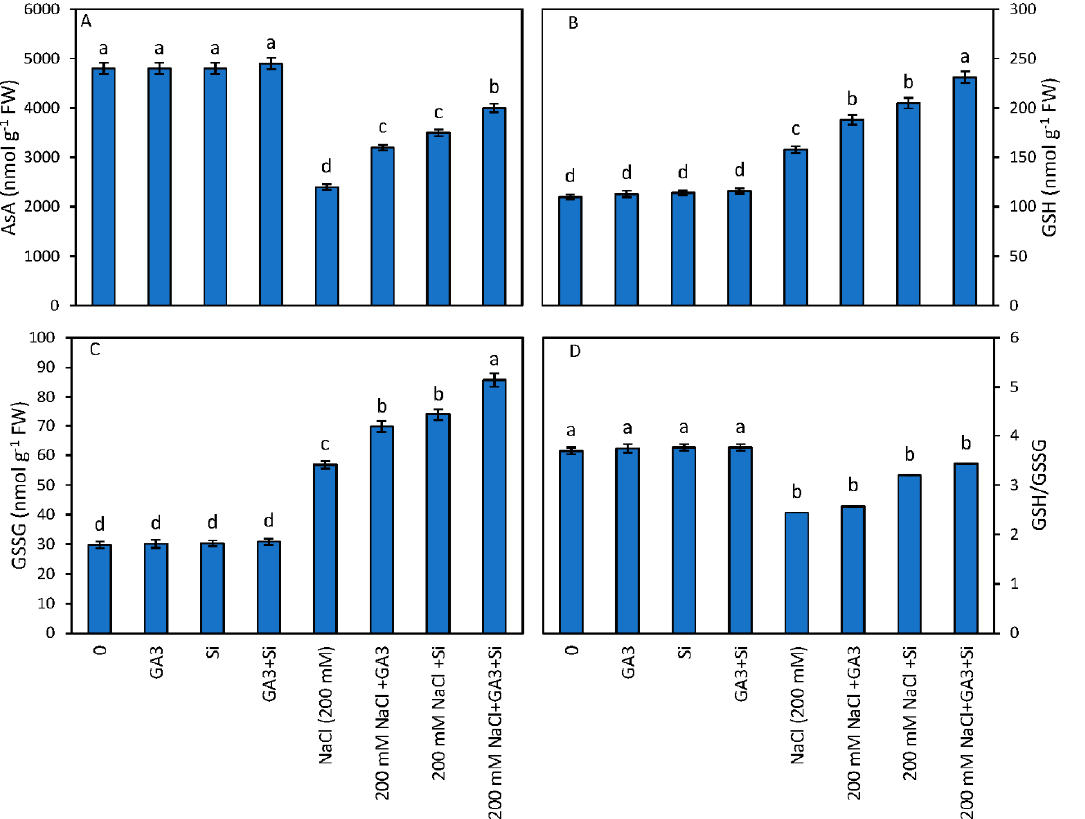
Figure 2. Effect of GA 3 and Si application on ( A ) AsA, ( B GSH, ( C ). GSSH and ( D ). GSH/GSSG of B. juncea in relation to NaCl stress. Mean on the column bar that shares a letter with the other entries is not significantly different at p ≤ 0.05 (Bonferroni Test).